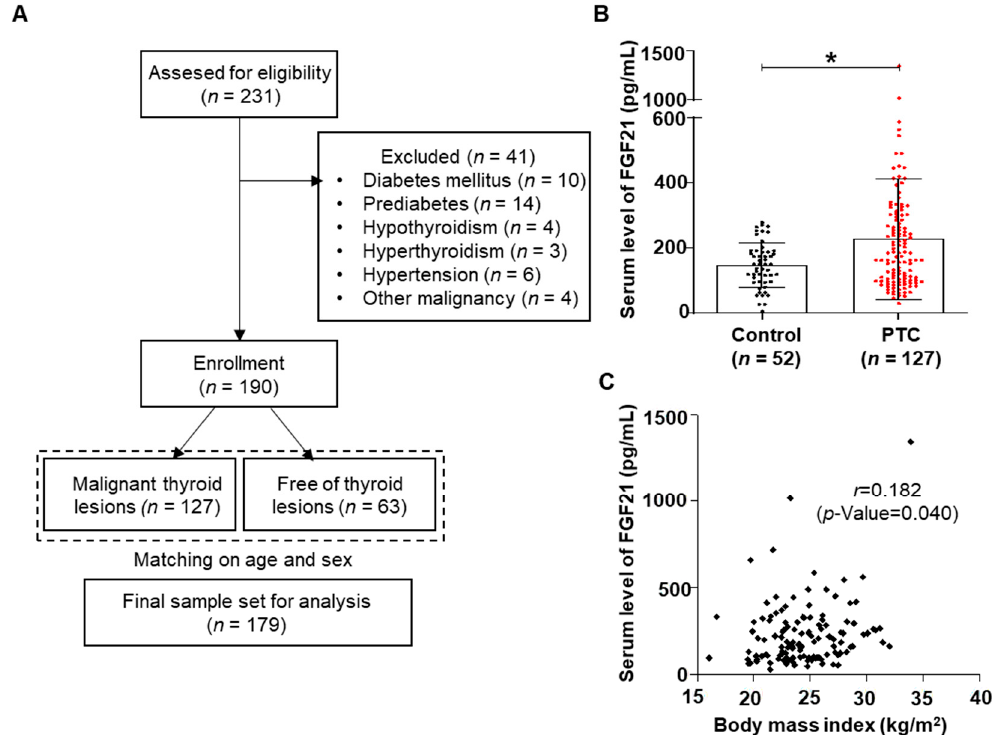
Figure 1. Thyroid cancer and serum levels of fibroblast growth factor 21 (FGF21). ( A ) The overall study design, including the numbers of participants included in this study. ( B ) Serum FGF21 levels in patients with papillary thyroid cancer (PTC) were significantly higher than in control subjects (* p < 0.05). ( C ) Serum FGF21 levels in PTC patients correlated positively with the body mass index.